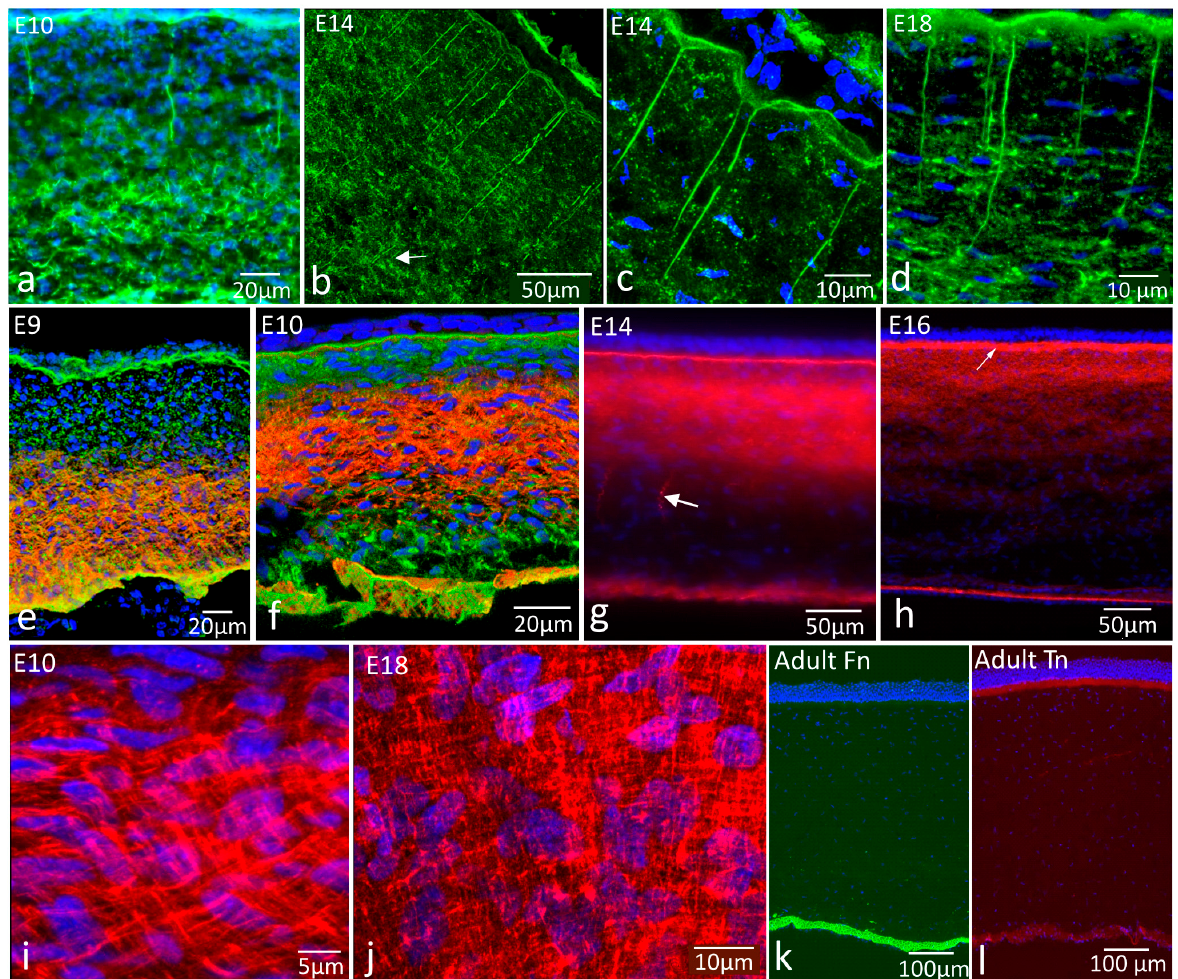
Figure 2. Immunohistochemistry for fibronectin (green) and tenascin-C (red) organisation in corneal development and morphogenesis. E9–Adult: distinctive glycoprotein networks persist, with some age-related changes, into late development but are lost in the adult cornea. Abbreviations: epi, epithelium; en, endothelium; Fn, fibronectin; Tn, tenascin-C. ( a ) E10 cornea, fibronectin label. Fibronectin strings (arrowheads) extend downwards from the epithelial basement membrane, while deeper in the stroma, there is a network of fibronectin cords (arrows) between keratocytes; ( b ) E14 cornea, fibronectin label. Numerous fibronectin strings (arrowheads) extend downwards into the cornea from their attachment points at the epithelial basement membrane. The fibronectin strings extend at least 100 µ m, with some possibly further (arrow), although these could not be traced back to the basement membrane due to section plane; ( c ) E14 cornea, fibronectin label, higher magnification. Fibronectin strings (arrowheads) attach to the base of roughly conical depressions in the basement membrane. Strings were not always continuous, with gaps frequently being observed along them (arrow); ( d ) E18 cornea, fibronectin label. Fibronectin strings (arrowheads) were present, extend- ing downwards through the anterior stroma and apparently ending in fibronectin-rich regions of the stroma (arrows) approximately 50–60 µ m from the basement membrane; ( e ) E9 cornea, dual label. Tenascin-C occupies only the posterior region of the stroma, whereas fibronectin is distributed throughout; ( f ) E10 cornea, dual label. Tenascin-C is distributed more centrally, with regions of weaker label anteriorly and posteriorly. Fibronectin is distributed throughout the stroma; ( g ) E14 cornea, tenascin-C label. Tenascin-C occupies the anterior half of the stroma, with a weaker region of label between it and the strongly labelled Bowman’s layer. Tenascin-C is also present in occasional elongate string-like structures, distinct from the fibronectin strings, in deep regions of the